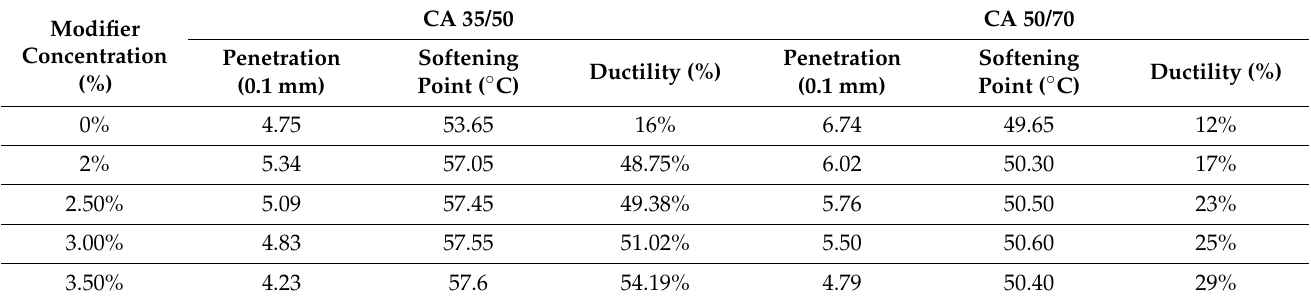
Table 1. Basic properties of bitumen and modi fi ers.